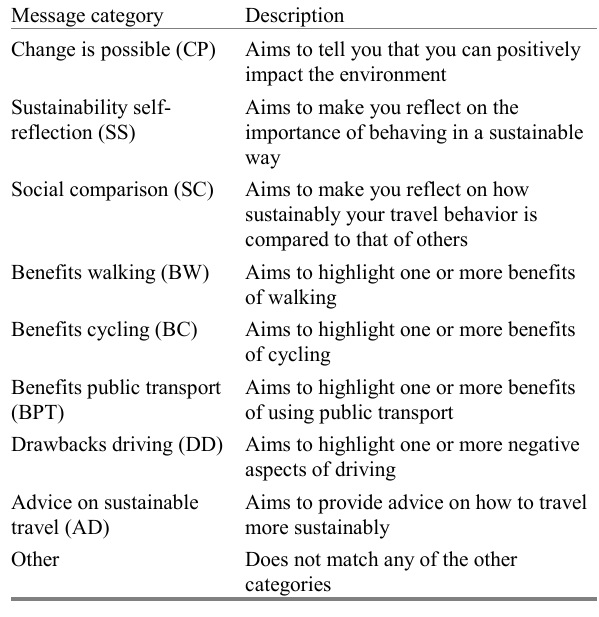
Table 2. Message categories devised by the authors Message category